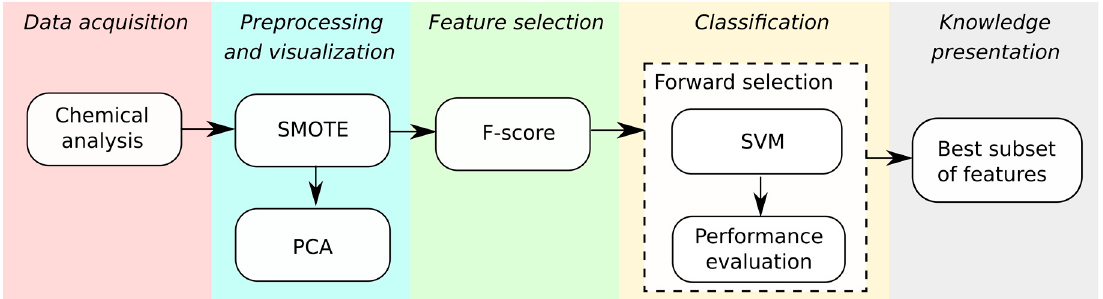
Figure 1. Schematic view of the Tannat wines analysis.